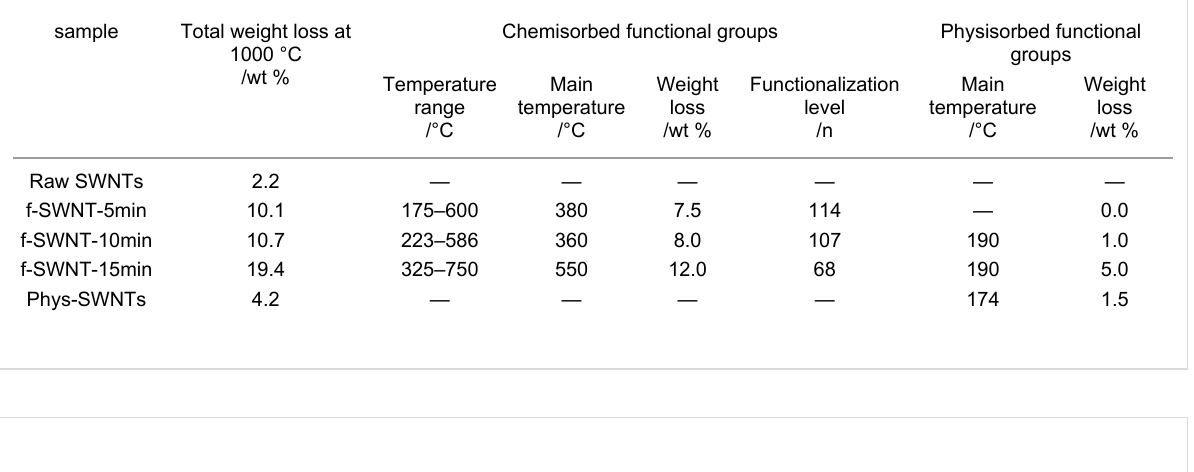
Table 1: Weight loss, temperature ranges for the physisorbed and chemisorbed functional groups, and the corresponding functionalization level.